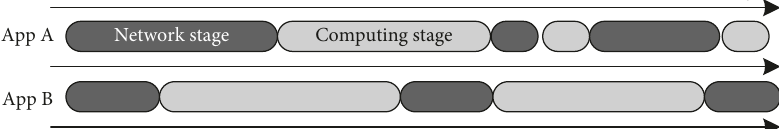
Figure 6: The explanation of the network episode and computing episode.